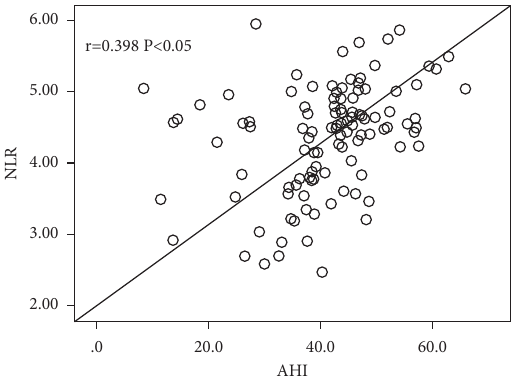
Figure 4: Correlation of AHI and NLR in patients with TBAD patients with OSA (group A). The likelihood of NLR significantly increased along with elevated AHI, namely, the severity of OSA ( r � 0.398, P < 0 . 05); AHI, apnea, and hypopnea index; NLR, neutrophil-to-lymphocyte ratio; r represents the correlation coefficient.